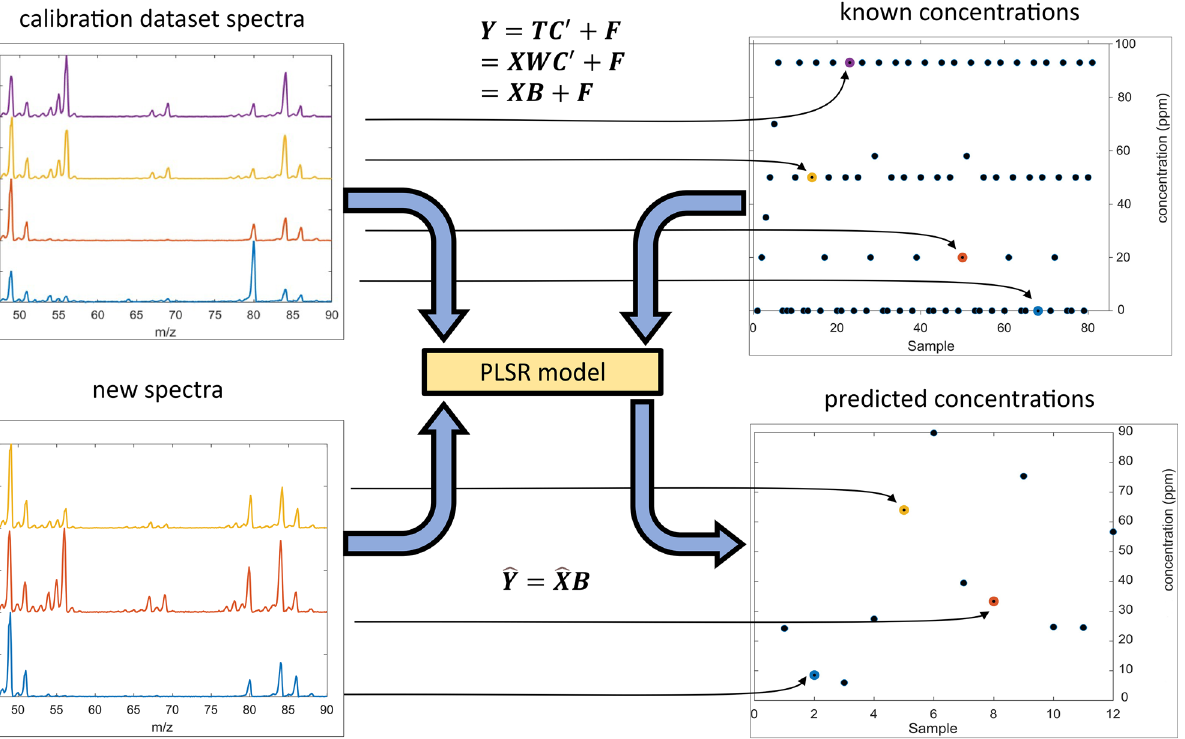
Figure 2. Partial Least Square Regression (PLSR). The X calibration dataset (upper-left) represents the spectra obtained with the mass spectrometer, each linked with the respective C 6 H 12 concentration ( Y calibration dataset, upper right). The datasets are used as input for creating a PLSR model and calculating an array of calibration coefficients B , allowing us to create the model to infer unknown concentrations